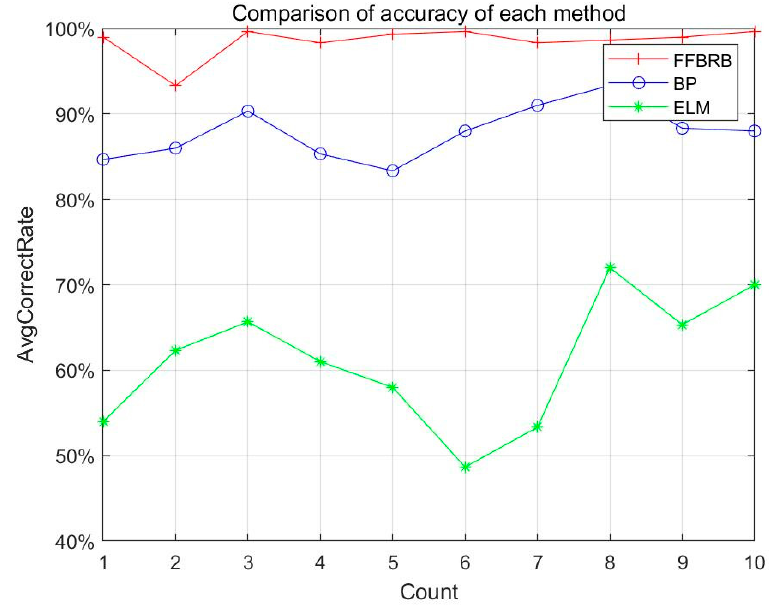
Figure 14. Comparison of experimental accuracy of different methods.